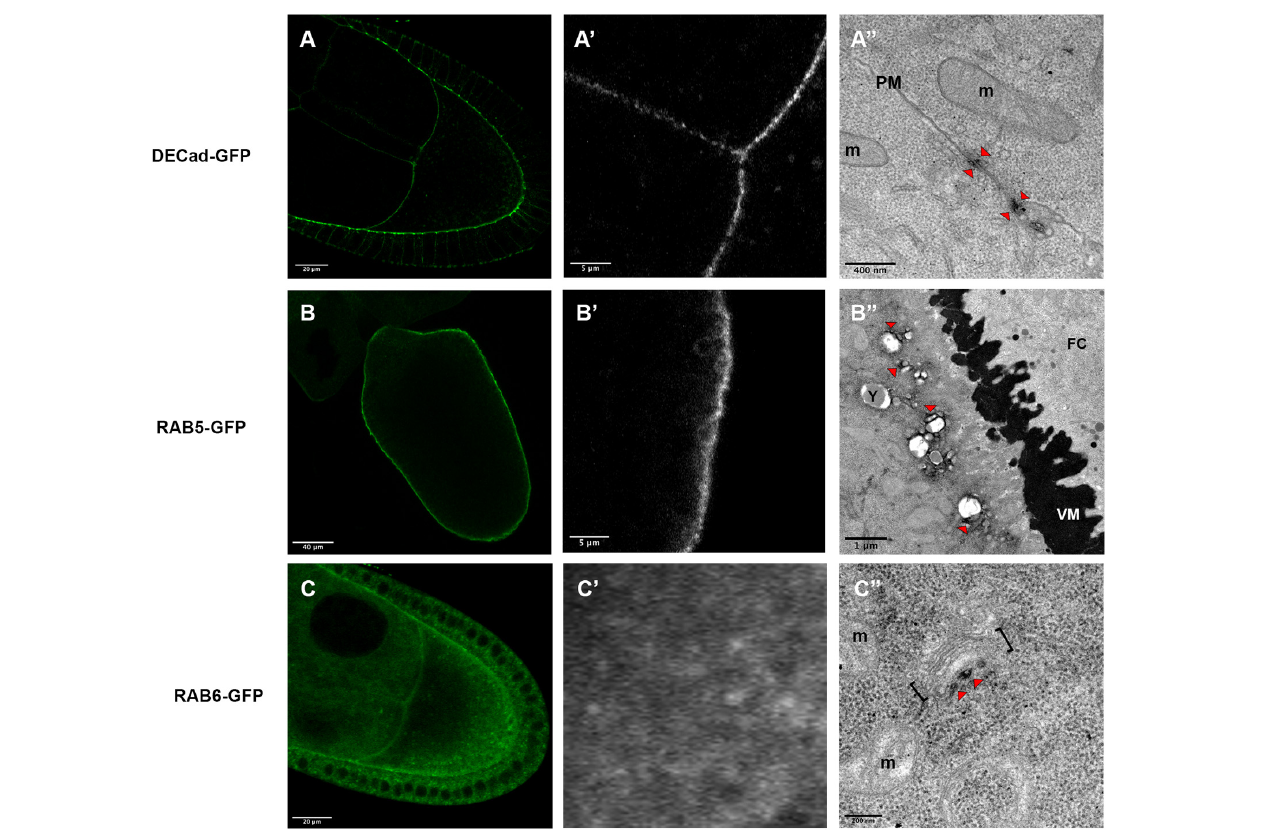
FIGURE 4 | Expression profiles of DE-Cad-GFP (A–A”) , Rab5-GFP (B–B”) and Rab6-GFP (C–C”) , revealed by fluorescent microscopy (A,A’,B,B’,C,C’) or by electron microscopy (A”,B”,C”) . DE-Cad localizes at the plasma membrane [ (A) , higher magnification (A’) ]. DAB precipitates are visualized (arrowheads) near plasma membranes (PM) separating the oocyte and a nurse cell (A”) . Rab5 that has a cortical localization revealed by fluorescence [ (B) , higher magnification (B’) ], is detected at a small distance of the plasma membrane at the surfaces of vesicles [ (B”) , arrowheads)]. Rab6-GFP displays a diffuse cytoplasmic signal (C) with some dots revealed at higher magnification (C’) . By electron microscopy, DAB precipitates are detected in the vicinity of Golgi apparatus [ (C”) , arrowhead]. (m) mitochondria, brackets highlight a Golgi unit, (VM) vitelline membrane, (FC) follicular cells. Number of observations DE-Cad-GFP ( n = 4), Rab5-GFP ( n = 2) and Rab6-GFP ( n =